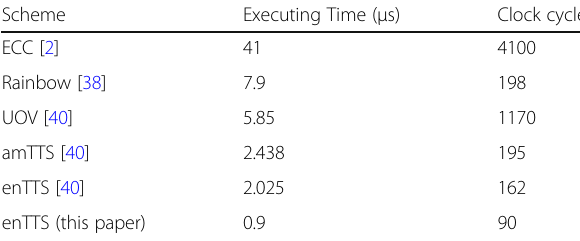
Table 3 Comparison on public key cryptographic